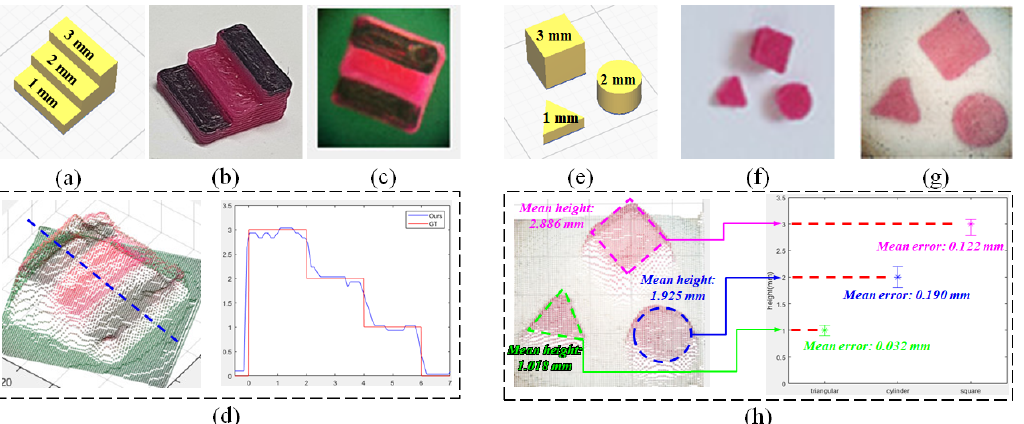
Figure 9. Measurement analysis; ( a ) 3D modeling for distance calibration, ( b ) printed 3D board, ( c ) central-view image of a 3D board, ( d ) real-distance 3D model and slice graph, ( e ) 3D modeling for measurement analysis, ( f ) printed test boards, ( g ) central-view image of test boards, and ( h ) real- distance 3D model and measurement analysis graph.